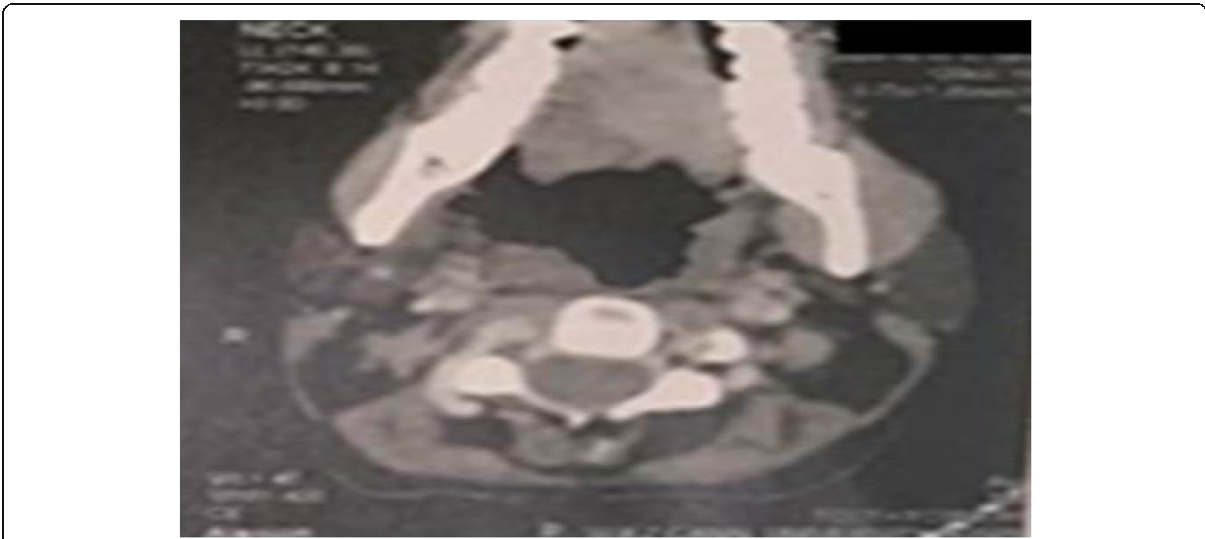
Fig. 3 Axial CT showing the oropharyngeal defect involving the right tonsillar area, palatoglossal fold, and extending toward the tongue